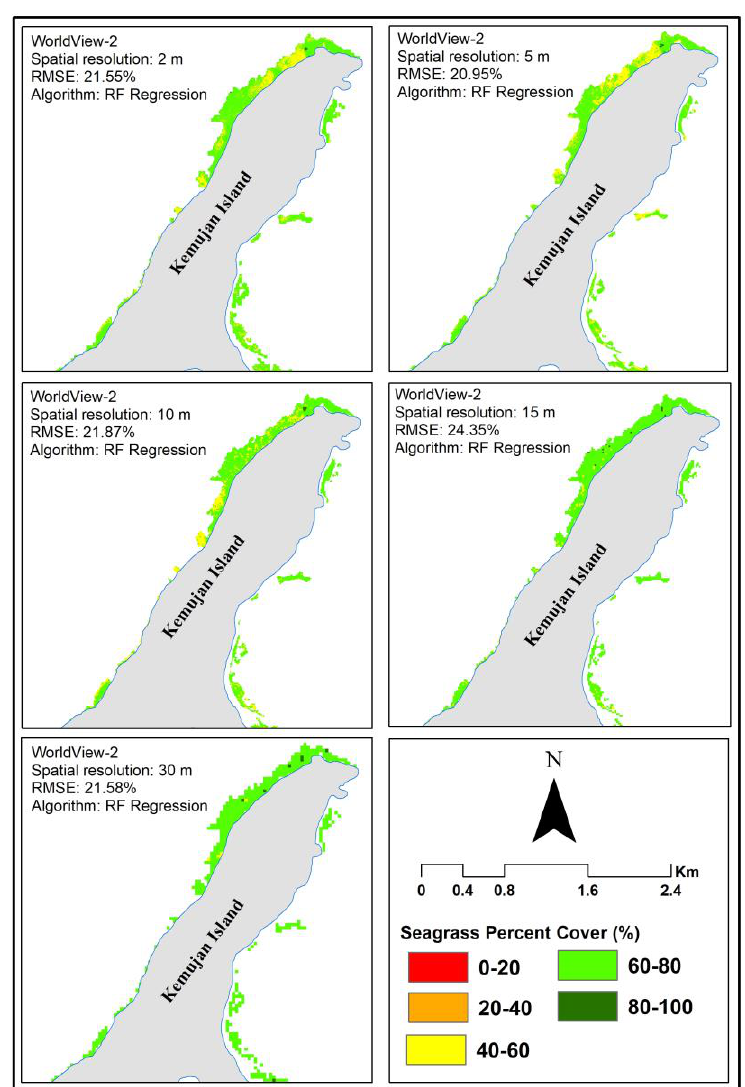
Figure 2. Seagrass percent cover map of Kemujan Island modelled from WorldView-2 image at different spatial resolutions